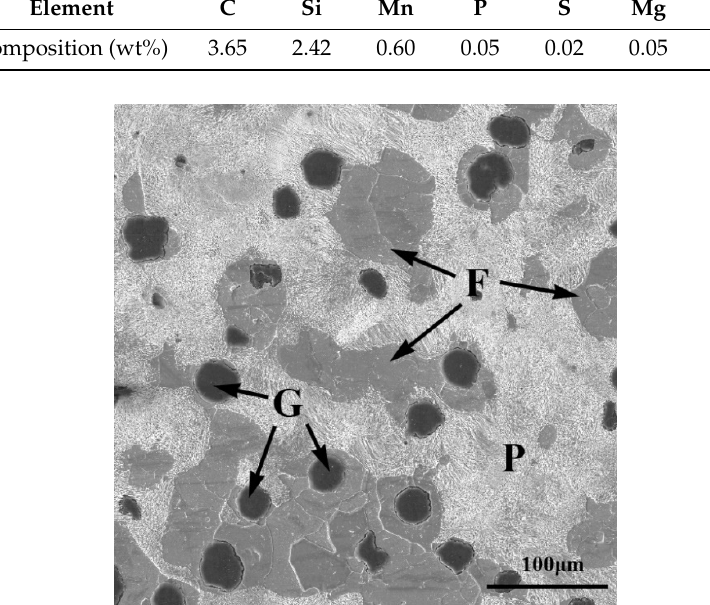
Table 1. Chemical compositions of nodular cast iron.